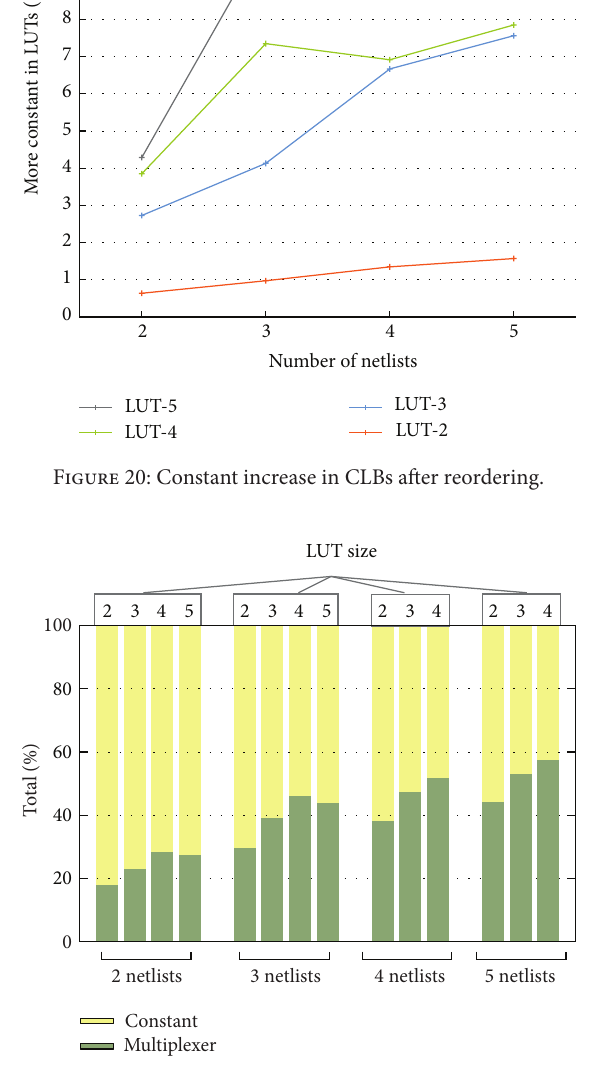
Figure 21: Percentage of replaced SRAM distribution after reorder- ing.